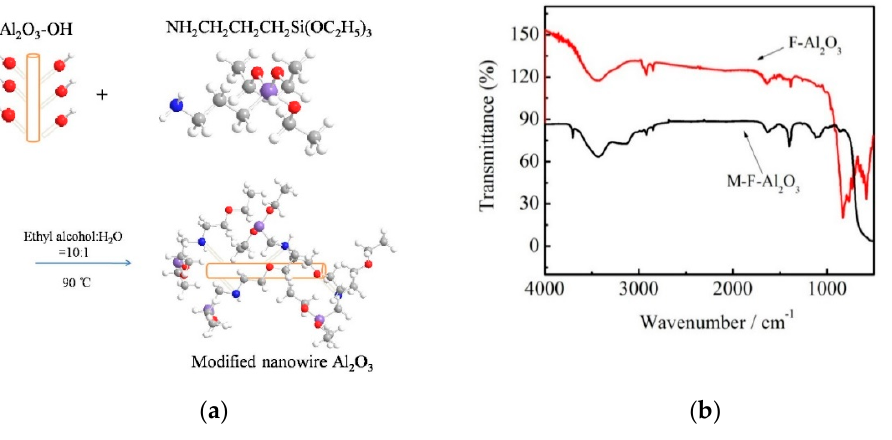
Figure 2. ( a )Schematic of modified Al 2 O 3 by KH550, ( b ) FT-IR curves of Al 2 O 3 fiber and modified Al 2 O 3 fiber. Al 2 O 3